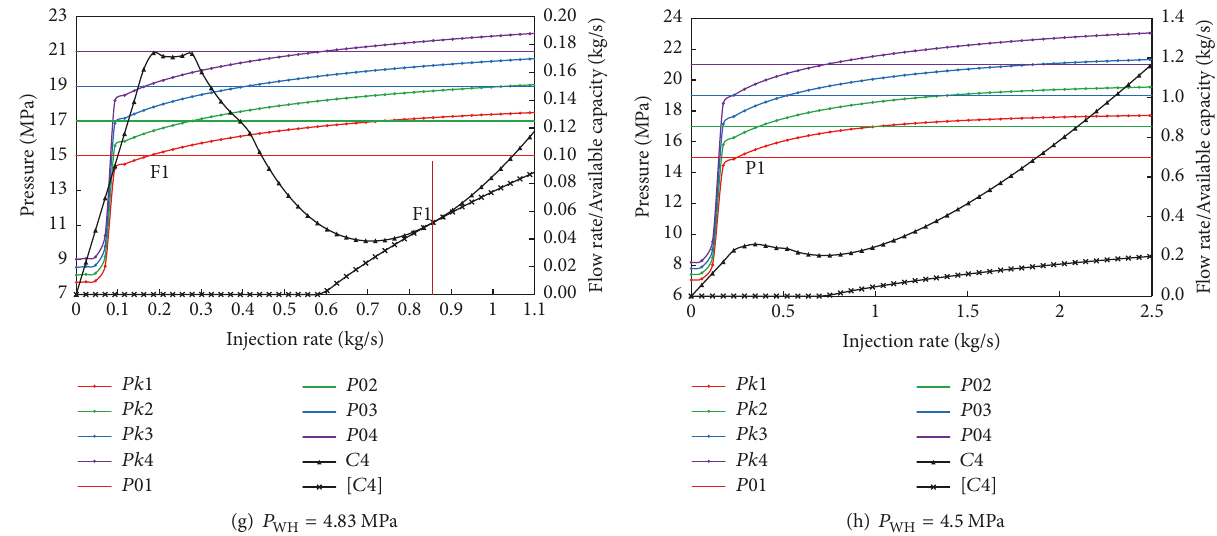
Figure 3: Curves of pressure and flow rate on the interface of wellbore and reservoir along with injection rate.